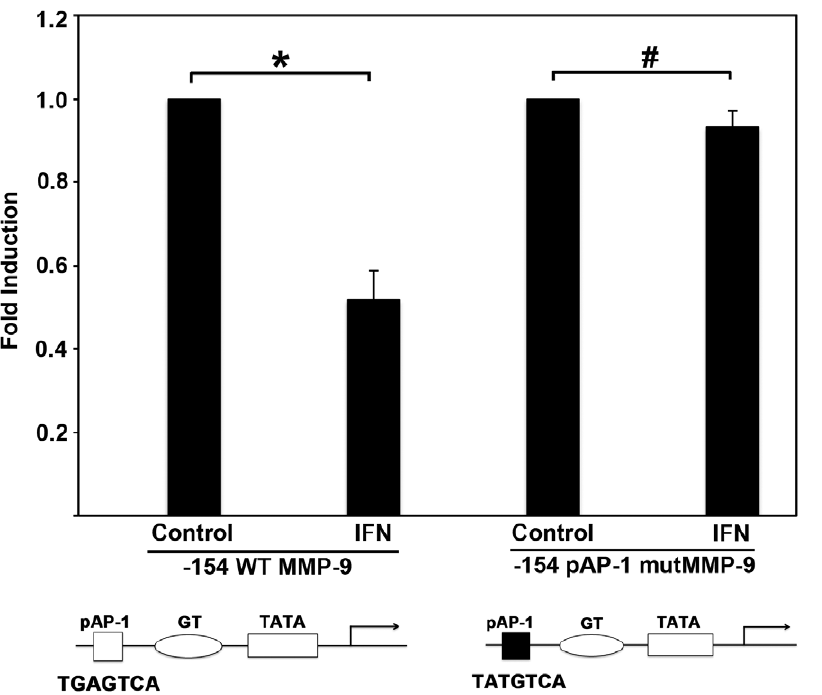
Figure 2. Loss of IFN b mediated repression of MMP-9 promoter when the binding of AP-1 to the proximal site is abrogated. HT1080 cells were transfected with 2 154 MMP-9 promoter deletion construct containing a point mutation in the proximal AP-1 site, which renders the binding site non-functional. Cells were prepared as described previously and were treated with 100 U/mL IFN b for 18 hours prior to preparation of cell extracts. Cell extracts were assayed for firefly luciferase activities, and normalized by protein concentration to account for any cell concentration differences between samples. Black bars: untreated values considered as 1 for each construct, white bars: IFN b treated. The experiment was repeated three times and the error bars represent standard deviation calculated from three separate experiments. The P-values were calculated using statistical analysis software. As indicated above the bars, * symbol indicates a P value of 1.8 6 10 2 4 (significant difference) and the symbol # indicates a P value of 0.092 (no significant difference), with significant values being ,